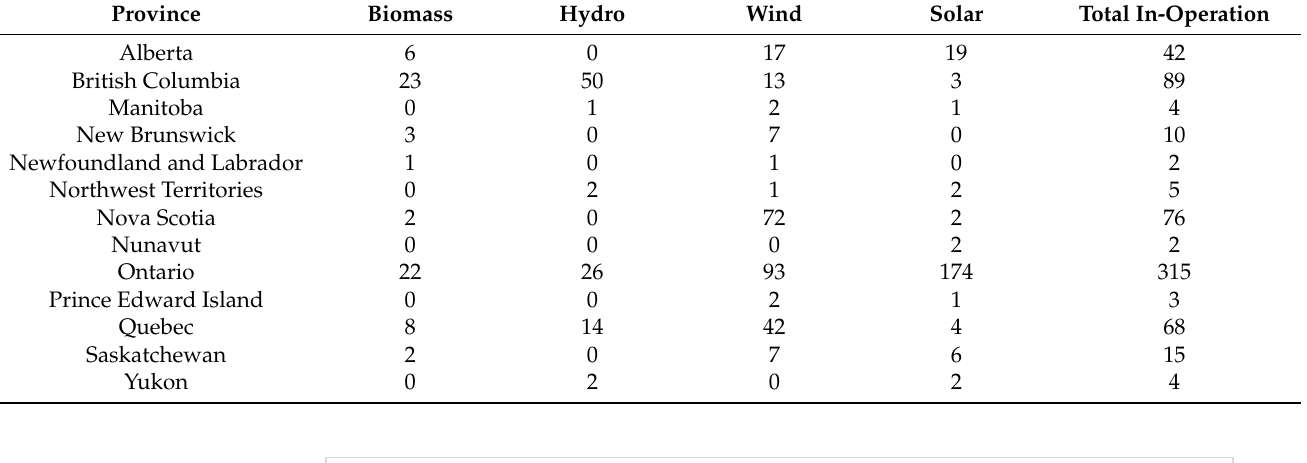
Table 1. Number of deployed renewable energy technology projects in remote communities of Canada [31,33,88].